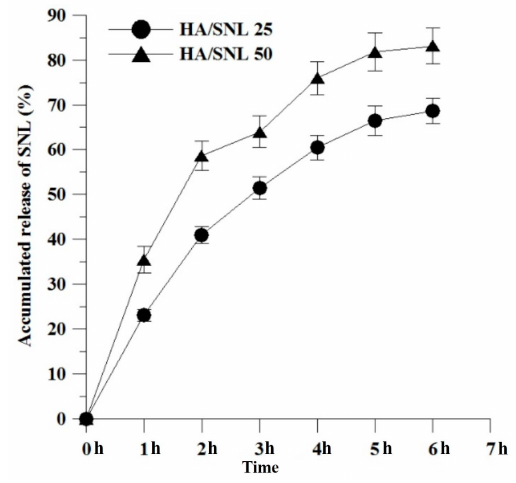
Figure 2. In vitro release profiles of SNL from HA/SNL25 and HA/SNL50 aggregates in PBS (pH